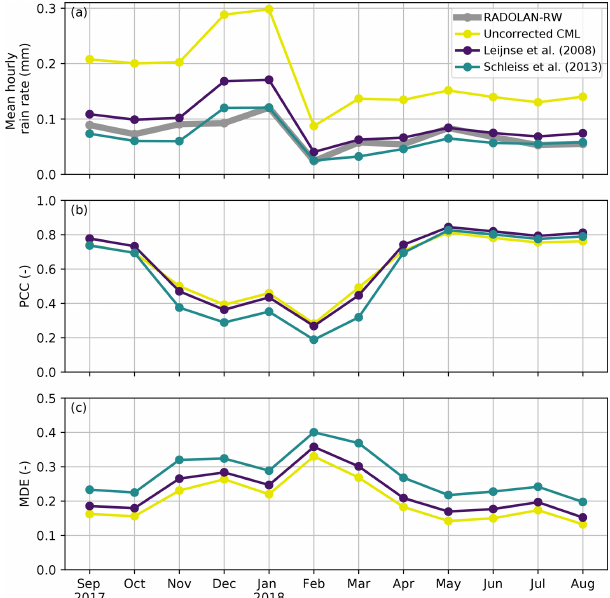
Figure 5. Wet antenna attenuation compensation schemes com- pared with respect to their influence on the (a) mean hourly rain rate, (b) the correlation between the derived rain rates and the ref- erence, and (c) the mean detection error between the derived rain rates and the